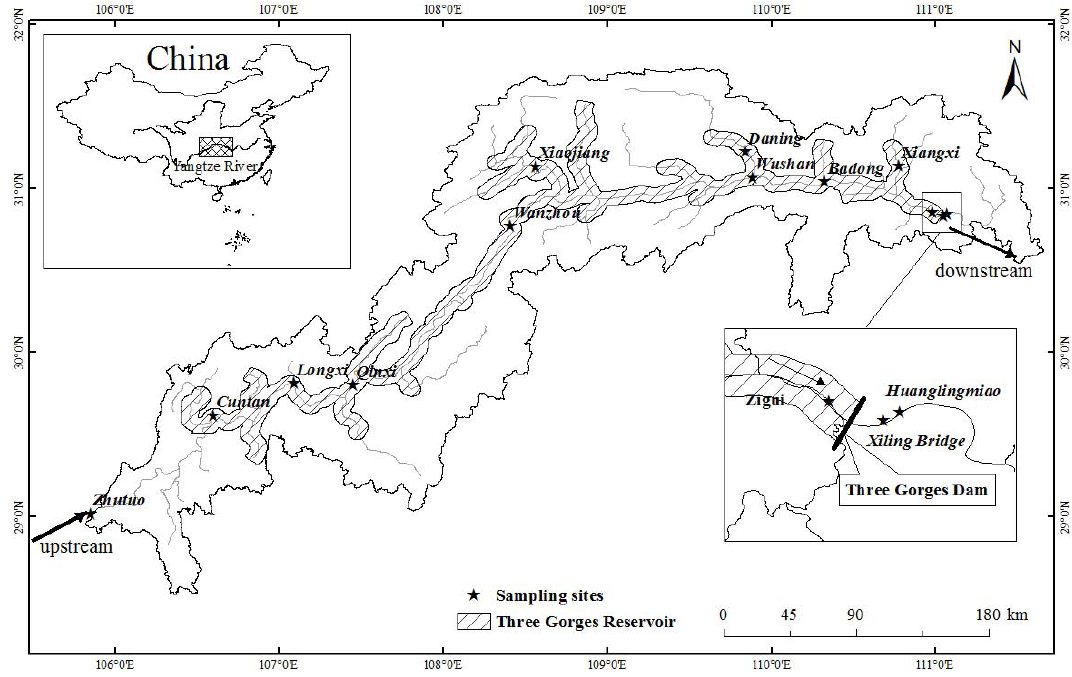
Fig. 1. Location of the Three Gorges Reservoir and sampling sites. Fluxes of CO 2 , CH 4 , and N 2 O through the water surface were measured from the following: seven mainstream sites, i.e., ZG (Zigui), BD (Badong), WZ (Wanzhou), QX (Qinxi), LX (Longxi), and CT (Cuntan); three tributaries, i.e., XR (Xiangxi River), DN (Daning) and XJ (Xiaojiang); two downstream sites, i.e., XLB (Xiling Bridge) and HLM (Huanglinmiao); and one upstream site of ZT (Zhutuo). Among them, ZG, BD, WZ and XR were measured monthly from January to December of 2010. All the other sites were measured from June 2010 to May 2011.